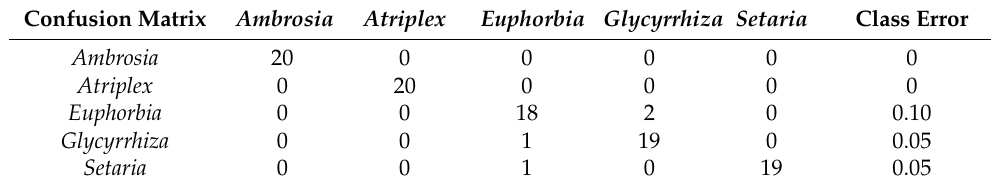
Table 15. Confusion matrix for weed identification by D1, Datt3, PSND, and DPI. Confusion Matrix